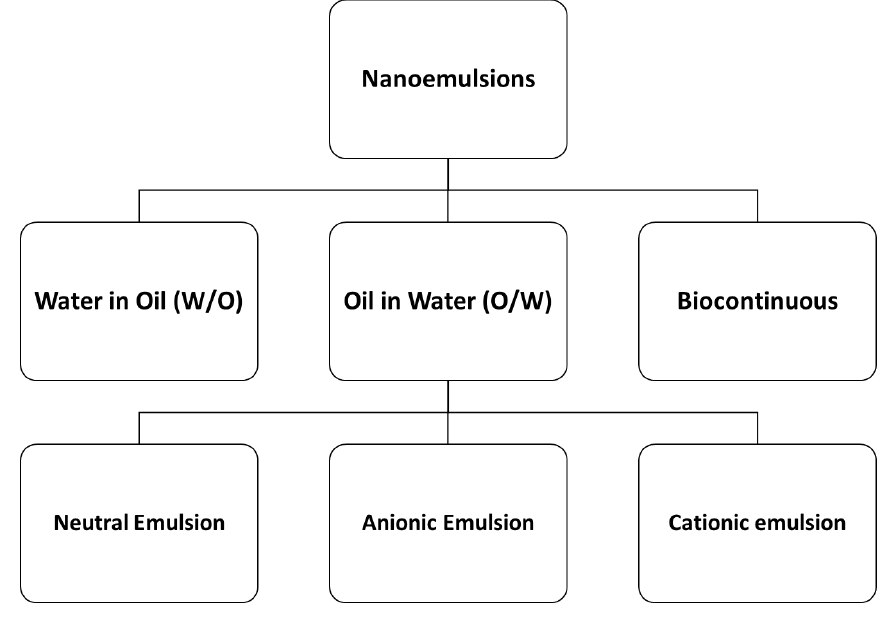
Figure 5. Types of NEs.